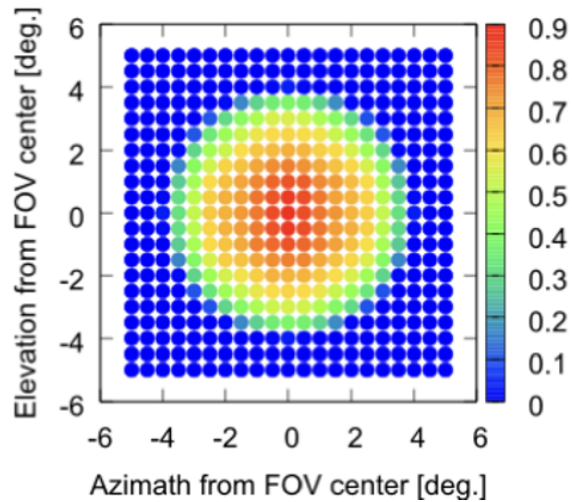
Figure 13. The light collection e ffi ciency at the focal plane for each incident